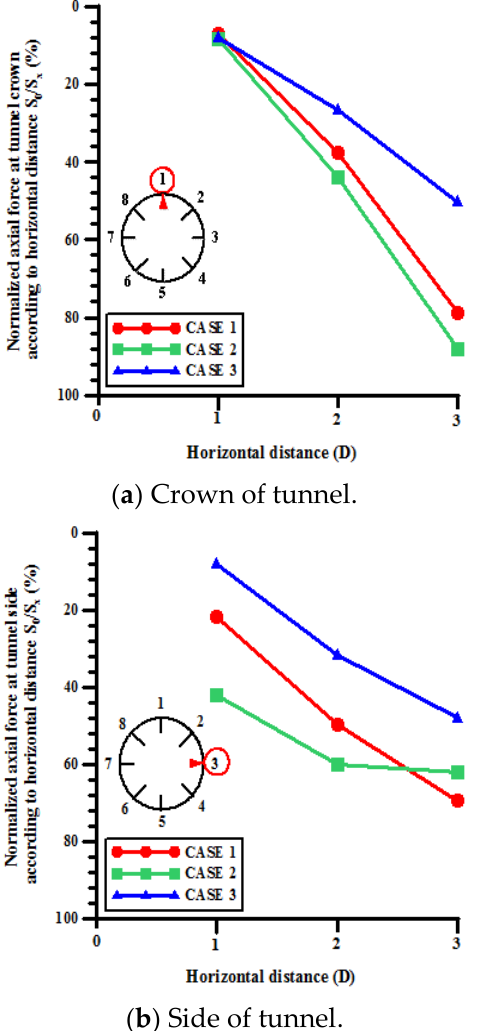
Figure 25. Normalized axial force by allowable load according to horizontal offset (3D numerical analysis).